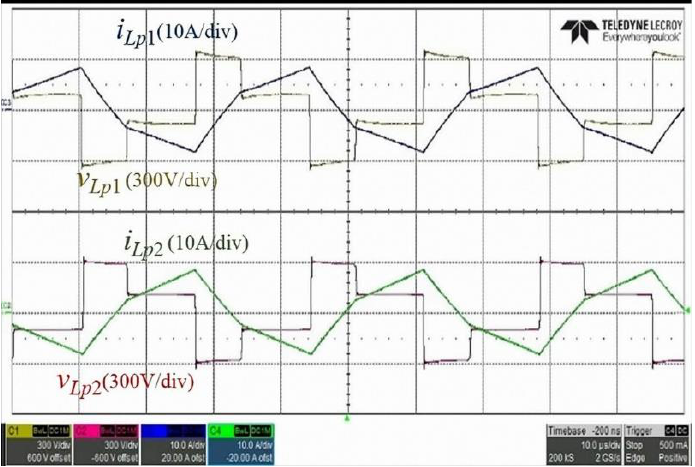
Figure 16. Experimental waveforms of the battery module voltage and current of the transformers.